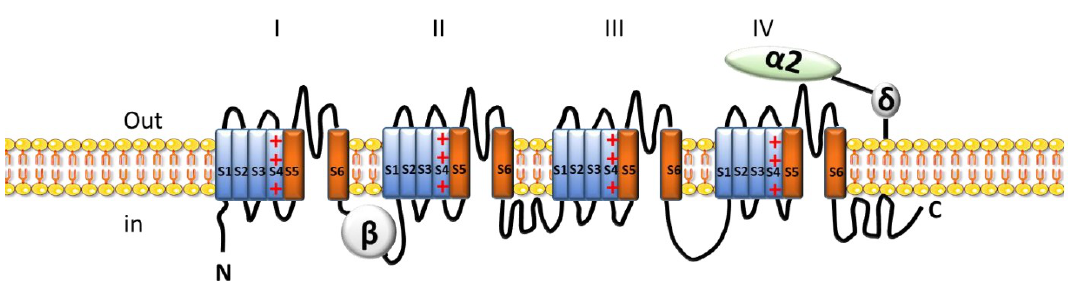
Figure 6. Schematic illustration of high voltage-activated (HVA) L-type Ca 2+ -channels. α subunit composed of the N terminus, the four homologous domains with six transmembrane segments, and a reentrant pore loop in each (I–IV), and the C-terminus.